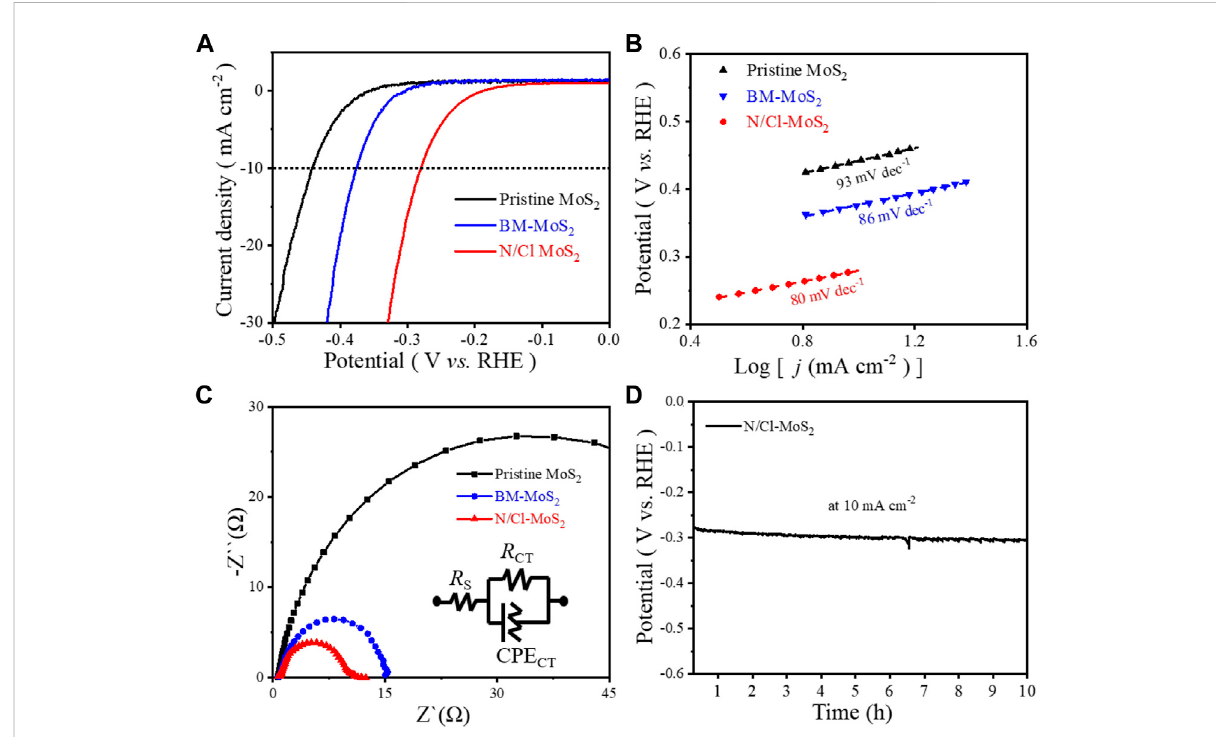
FIGURE 4 (A) LSVpolarization curves for pristine MoS 2 , BM-MoS 2 , and N/Cl-MoS 2 . (B) Tafel plots for pristine MoS 2 , BM-MoS 2 ,and N/Cl-MoS 2 . (C) Nyquist plots for pristine